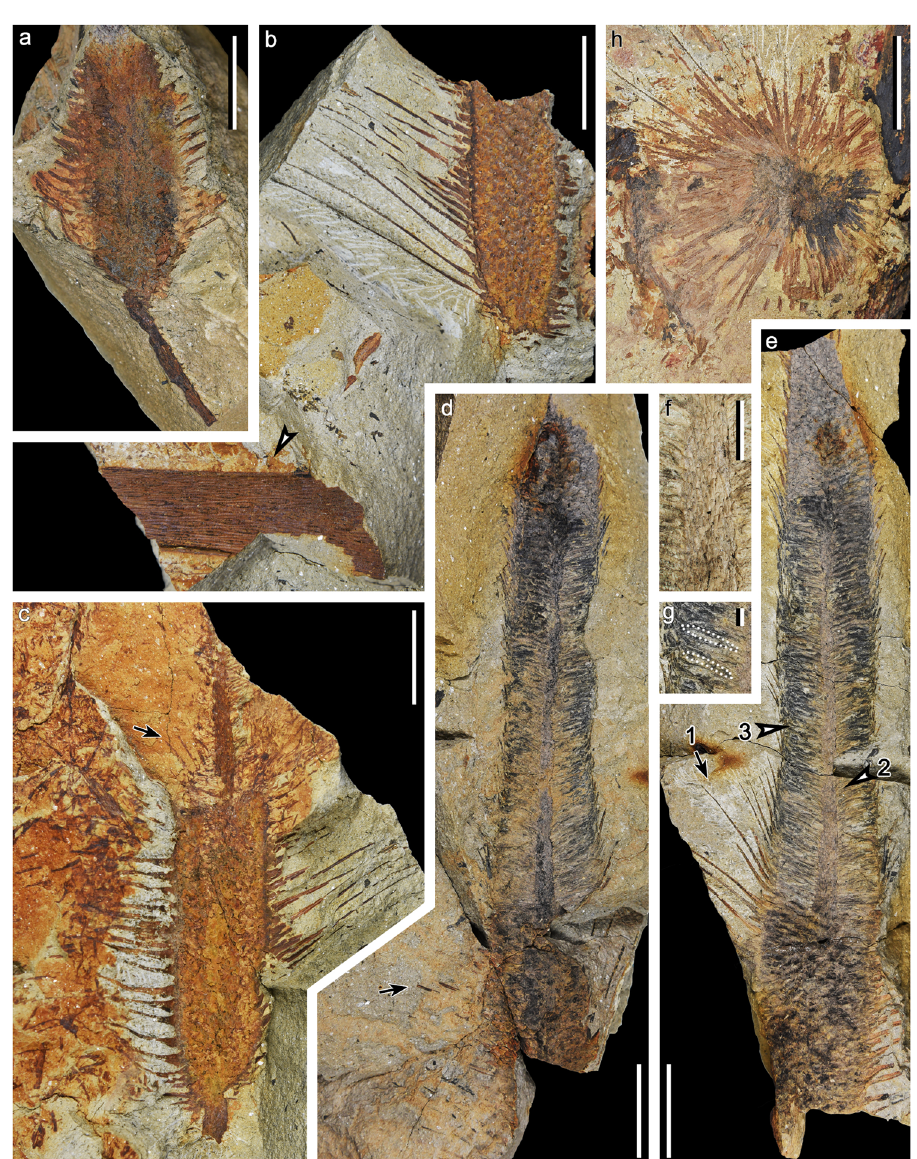
Fig. 4 Strobili of Omprelostrobus gigas gen. et sp. nov. Scale bars: a – e, h, 2 cm; f, 5 mm, g, 2 mm. a A strobilus terminating fertile axis. PKUB19307. b Strobilus displaying long linear sporophyll laminae along one side. Arrow indicating associated axis enlarged in Fig. 1h. c A strobilus terminating fertile axis, displaying sporophyll laminae along both sides. Arrow indicating the sporophyll laminae shorten and bend towards the tip of the strobilus at the boundary between the proximal and distal portions. PKUB19308. d , e Part and counterpart of a strobilus. Arrow in d indicating sporophylls in rock matrix. Arrow 1 in e indicating the sporophyll laminae shorten and bend towards the tip of the strobilus at the boundary between the proximal and distal portions. Arrows 2 and 3 in e indicating portions enlarged in f , g , respectively. PKUB19309A, B. f Enlargement of e (arrow 2). Strobilar axis with scars of sporophyll pedicels. g Enlargement of e (arrow 3). Dotted lines indicating contours of sporangia. h Probable strobilus with radiating sporophylls cutting across the bedding plane.